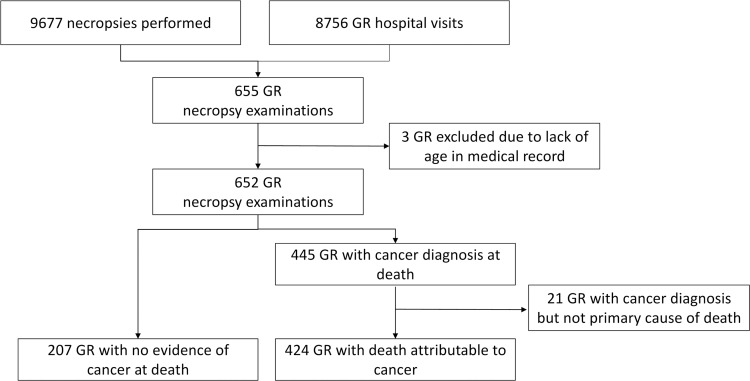
Study schema.Study schema showing cases included from 1989–2016 from an academic teaching hospital. GR = golden retriever dog.